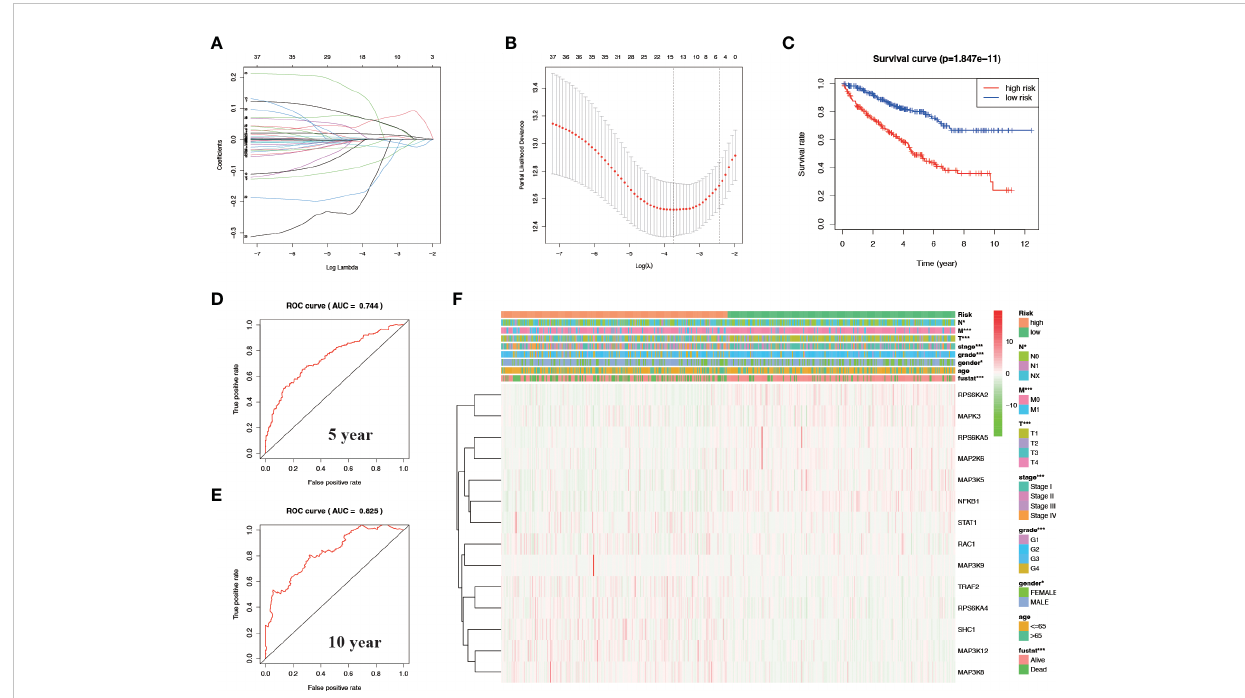
FIGURE 3 Construct a prognostic-related risk model in KIRC through LASSO regression analysis. (A, B) Results of LASSO regression analysis and cross- validation. (C) Kaplan – Meier survival analysis between high-risk and low-risk groups according to the optimal cut-off value; (D) ROC curve for predicting 5-year survival time; (E) ROC curve for predicting 10-year survival time; (F) Heat map based on the correlation of this risk feature with clinical features. *P<0.05 and